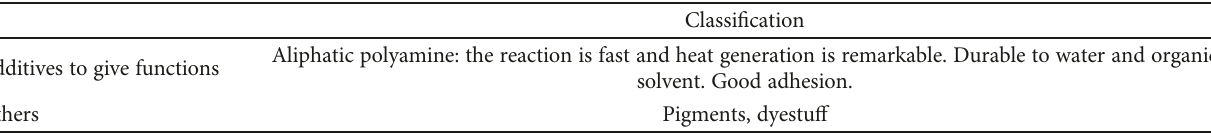
Table 4: Typical submaterials for epoxy resin adhesive.